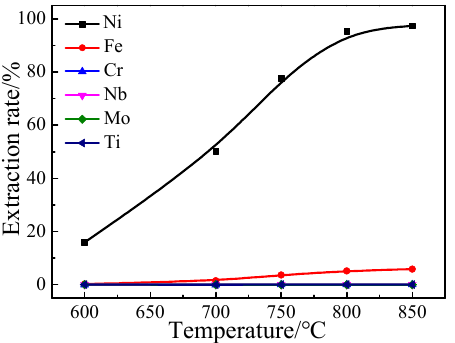
Figure 3. Effect of temperature on the extraction of metals (Note: the curves for Cr, Nb, Mo and Ti are overlapping).